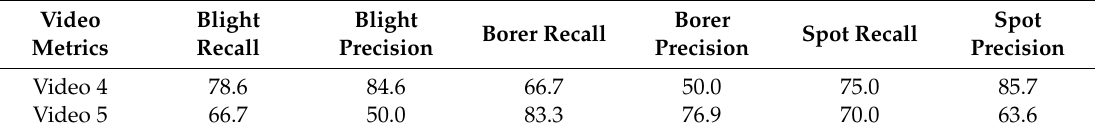
Figure 8. The custom DCNN video detection system qualitative results of Videos 4 and 5. ( a ) Video 4, which mainly has rice sheath blight. ( b ) Video 5, which mainly has rice stem borer symptoms. Red, purple and blue boxes denote rice sheath blight, rice stem borer symptoms, and rice brown spot respectively, and indigo ellipses magnify the lesion spots, which is realized by Adobe Photoshop CS6. The same kind of lesions is magnified once in each subgraph. Video 4 and Video 5 did not participate in model training. Video 4 was captured in Hunan Province, China, July 2018, Video 5 was captured in Table 5. Video metrics of Video 4 and Video 5 with the custom DCNN system (%). Video 4 and Video 5 were used for validating the system further.